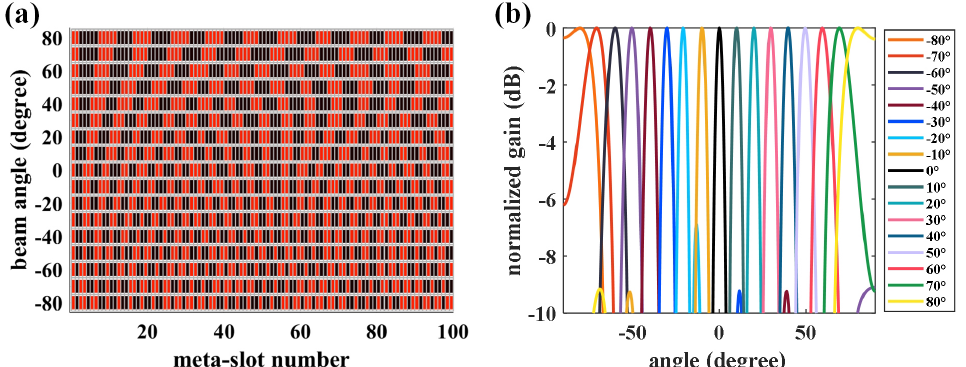
Figure 2. Beam-steering characteristics of the graphene-biased terahertz coding meta-surface. ( a ) 1/0- states of per element. ( b ) Scanning